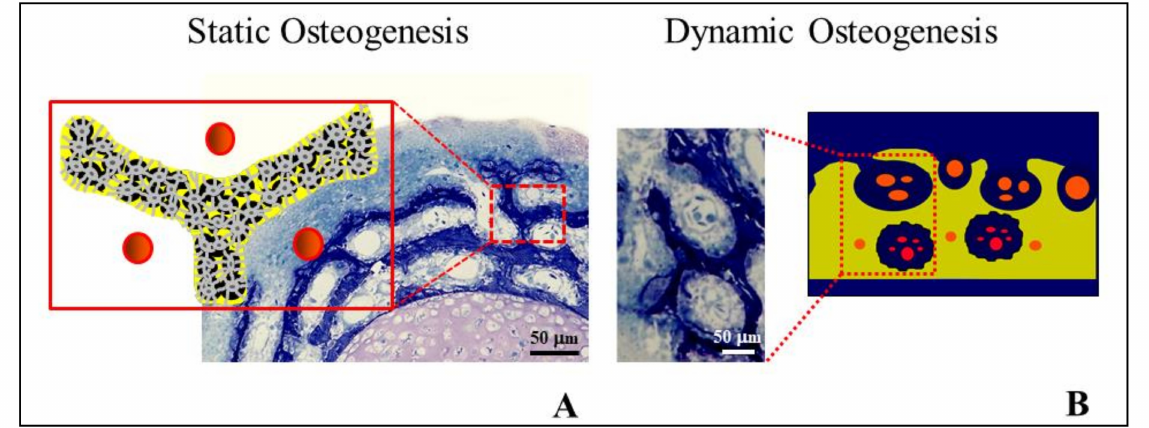
Figure 9. Cross-sections at the mid shaft level of the cartilaginous bud of a chick embryo showing: ( A ) SO trabeculae surrounding primary haversian spaces (the schematic drawing depicted in the insert represents the field of the square area in the histological section); ( B ) primitive vascular haversian spaces narrowed by means of DO (i.e., bone compaction), thickening SO trabeculae and giving rise to primary osteons (the histological section shows the field in the square in the schematic